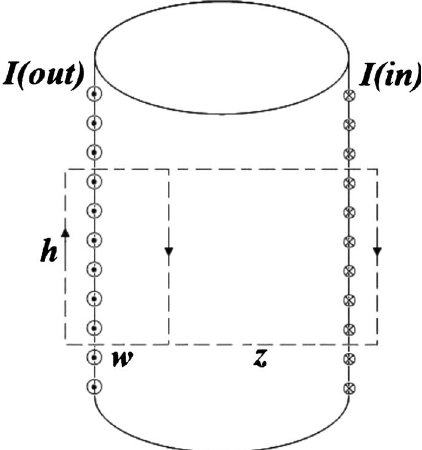
FIG. 5. The solenoid problem: Find the magnetic field of a very long solenoid with n closely spaced turns per unit length on a cyl- inder of radius R and carrying a steady current I . Adapted from example 5.9 in Griffiths (cid:4) 11 (cid:5) . The Ampèrian loops shown above were not given to students.